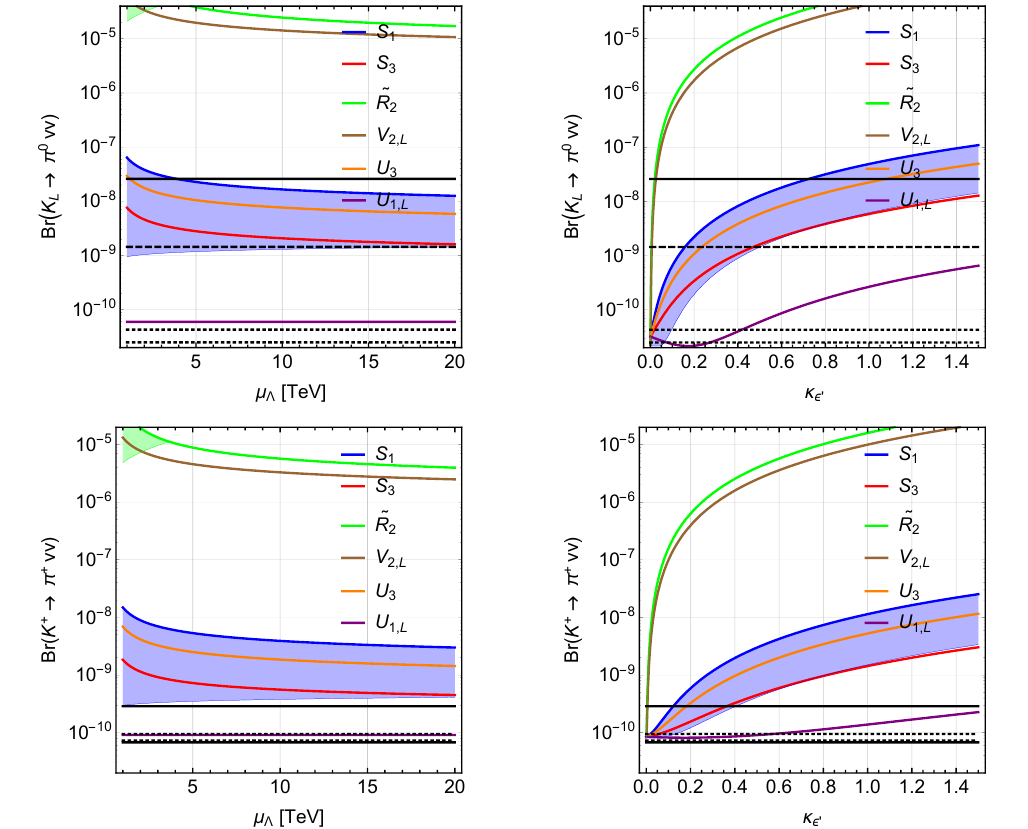
Figure 4. The dependence of B ( K L ! (cid:25) 0 (cid:23) (cid:22) (cid:23) ) [upper] and B ( K + ! (cid:25) + (cid:23) (cid:22) (cid:23) ) [lower] on the new physics scale (cid:22) (cid:3) (cid:24) M LQ for (cid:20) " 0 = 0 : 5 [left] and on (cid:20) " 0 for (cid:22) (cid:3) = 20 TeV [right], assuming the dominance of a single lepton-(cid:13)avour coupling that is purely imaginary. For U 1 ;L and V 2 ;L , it is assumed that only L -LQ couplings are present and saturate (cid:20) " 0 . The blue (green) band for S 1 ( e R 2 ) is due to variation of the box-diagrams via (cid:6) 11 2 [0 : 0 ; 1 : 0]. Further shown are the current upper R ( L ) experimental bound on B ( K L ! (cid:25) 0 (cid:23) (cid:22) (cid:23) ) and the measurement of B ( K + ! (cid:25) + (cid:23) (cid:22) (cid:23) ) [73] [black solid], the Grossman-Nir bound from the current measurement of B ( K + ! (cid:25) + (cid:23) (cid:22) (cid:23) ) [black dashed] and the SM prediction [21] [black